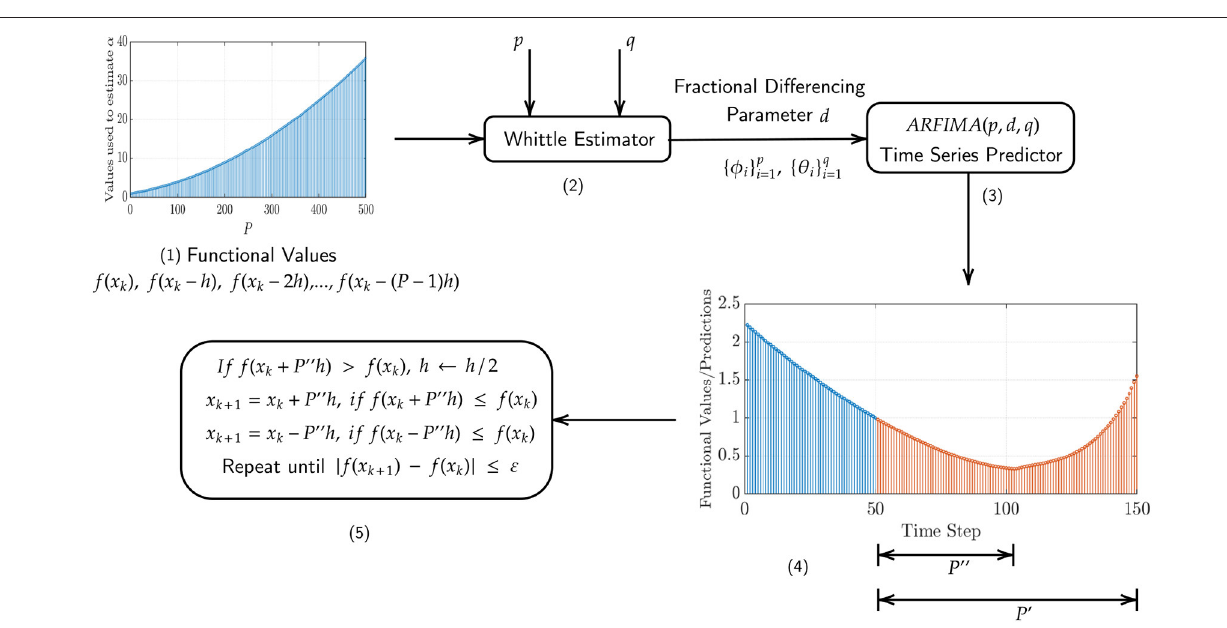
FIGURE 2 | Schematic representation of the NEO method. (1) The functional values f ( x 0 ), f ( x 0 by the Whittle estimator. (2) The Whittle estimator, which takes the aforementioned values as input and outputs the fractional differencing parameter d and the autoregressive and moving average coefficients Illustration of the largest possible value of P ′′